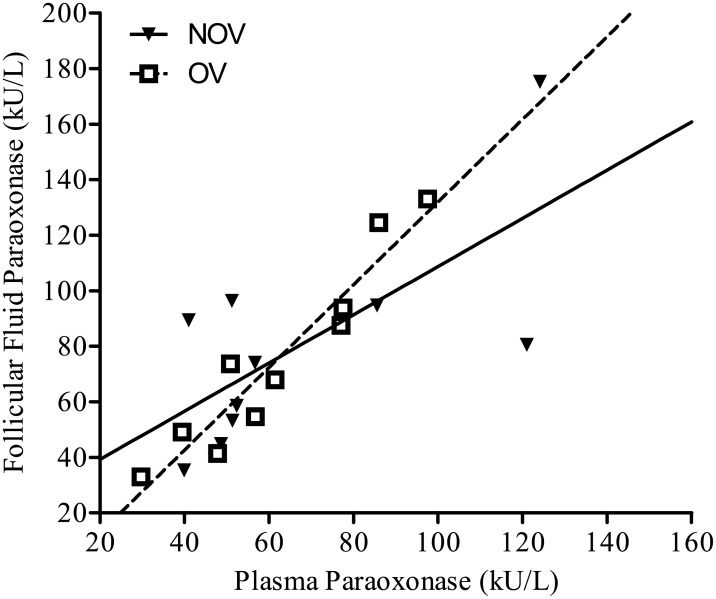
Scatterplot for follicular fluid and plasma paraoxonase.The association between the follicular fluid and plasma paraoxonase concentrations was linear and significant (P < 0.001). No differences were detected between OV and NOV groups.